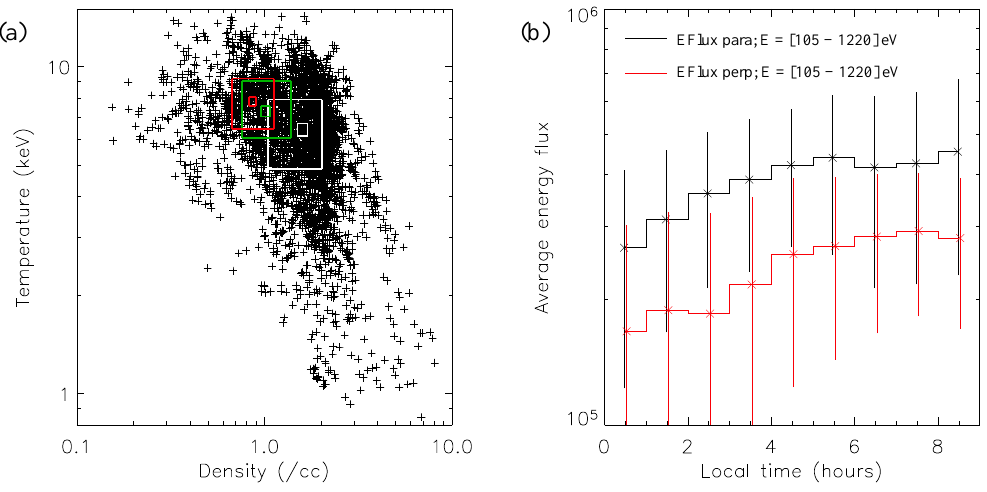
Fig. 6. (a) Scatter plot of all temperature and density measurements (black crosses) from the region having characteristics of the cold, dense plasma sheet (CDPS), between 23:00–01:00 LT and 00:00–00:30 epoch time. The white squares represent the temperature and density ranges which comprise 10% and 50% of the measurements, centered on the median values for each parameter. The red and green squares are equivalent and come from the measurements in the same local time range 23:00–01:00 LT, but, respectively, for the intervals − 03:00– − 02:30 and 06:00–06:30 in epoch time. (b) Local time distribution of the average energy flux (cm − 2 s − 1 sr − 1 ) measured in the morning sector, for the parallel (black) and perpendicular (red) directions and for the energy band 105–1220eV. The error bars show the average absolute deviation from the mean in each local time bin. These data come from a subset of 121 events observed by Los Alamos spacecraft